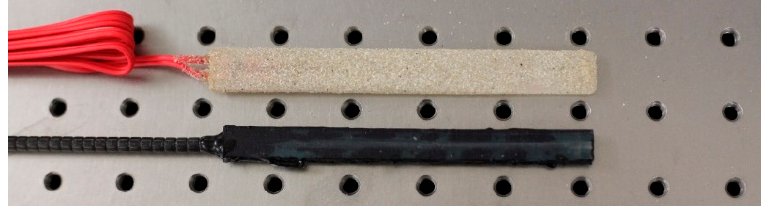
Figure 12. Packaged sensors: ersg top, FBG bottom.